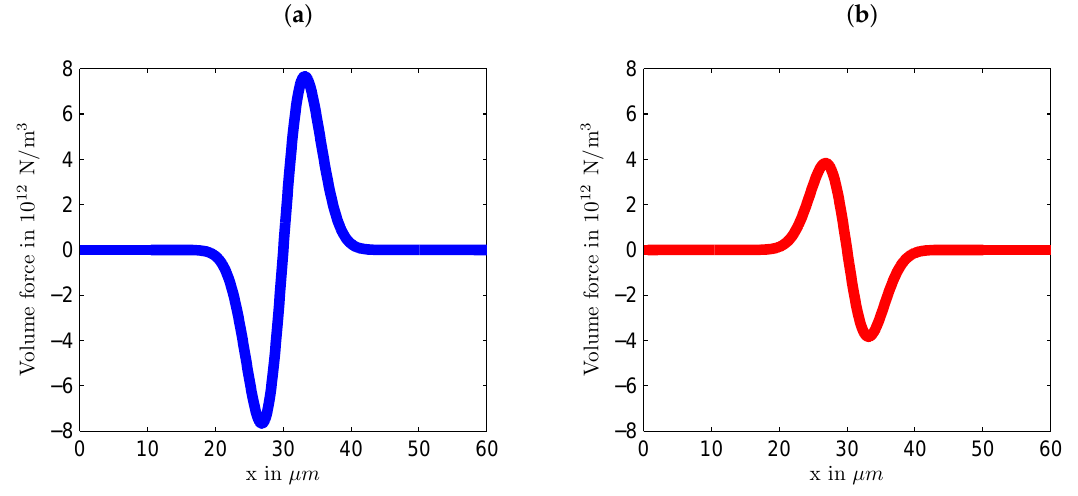
Figure 3. The x component of the volume force: ( a ) stretching for light polarized in x direction and ( b ) compressive for light polarized in y direction. τ 0 = 40 MPa. The beam radius w = 2